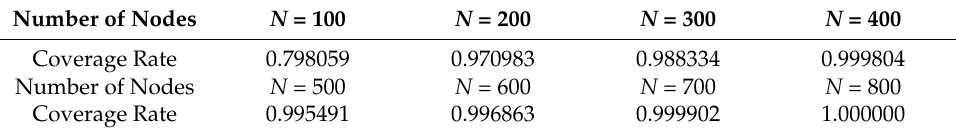
Table 2. Network coverage rate (100 m × 100 m).